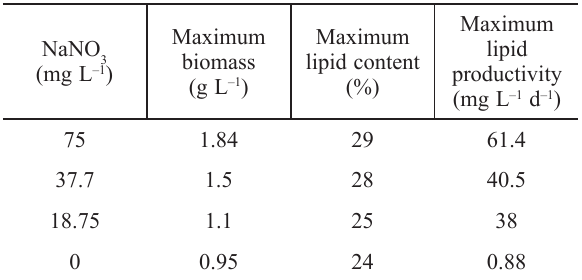
Table 1 – Effect of nitrogen variation on biomass, lipid con- tent, and lipid productivity